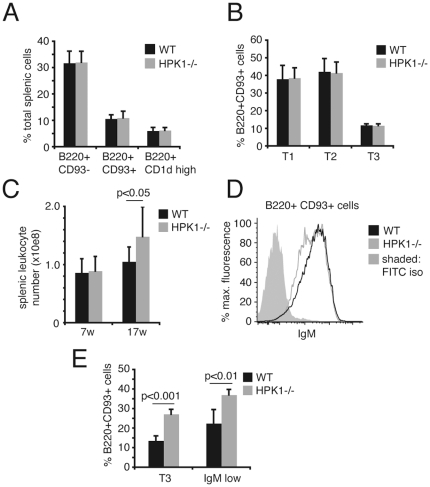
HPK1 deficiency has a late onset effect on splenic leukocyte numbers and surface IgM levels.(A,B) Splenic cells of 7 weeks old wt and HPK1−/− mice were stained with distinct cell surface markers to delineate peripheral B-cell development (A: mature B220+ CD93−, transitional (T) B220+CD93+, marginal zone B220+CD1d+; B: T1 B220+ CD93+ IgM+ CD23−/low, T2 B220+ CD93+ IgM+ CD23+, T3 B220+ CD93+ IgMlow CD23+; graphs: means ± SD; Student's t; n = 5). (C) Total splenic leukocyte counts of 7 and 17 weeks (w) old WT and HPK1−/− mice. (D) Surface IgM levels of aged (40 w) WT and HPK1−/− mice pre-gated on B220+CD93+ transitional B-cells (graph representative for 4 independent experiments). (E) Percentage of aged (40 w) wt and HPK1−/− T3/IgMlow cells gated on total transitional B220+CD93+ cells (graphs: means ± SD; Student's t; n = 4); iso, isotype control.